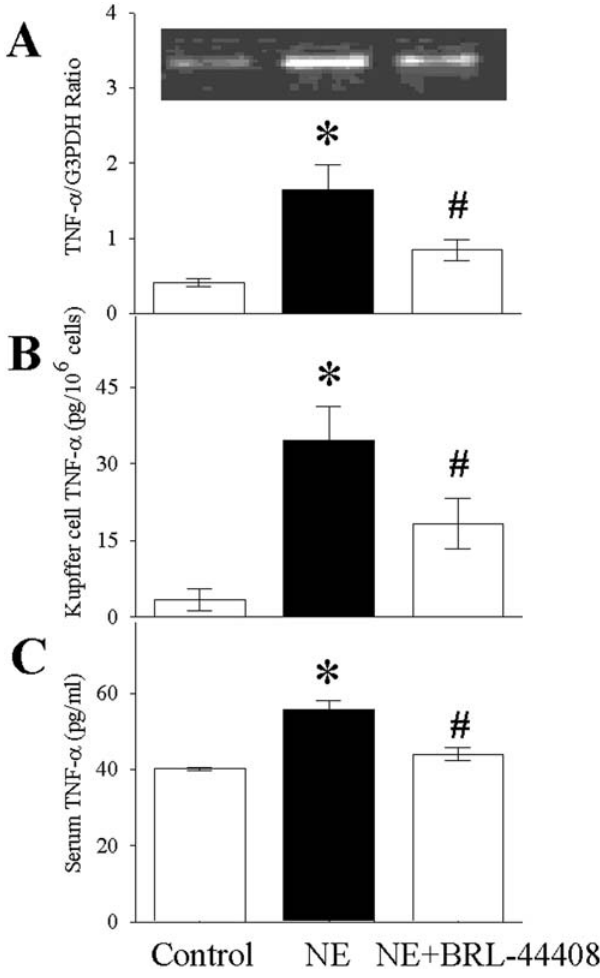
Figure 4. Portal infusion of NE induces a 2A -AR-dependent TNF- a production in KCs. In vivo Alterations in Kupffer cell gene expression ( A ) and protein levels of TNF- a ( B ) as well as serum TNF- a levels ( C ) after administration of NE, NE combined with BRL-44408 maleate for 2 h through the portal vein. A representative gene and ratio of TNF- a and housekeeping gene G3PDH are presented in panel ( A ). Values (n=5/group) are presented as mean 6 SE and compared by one- way ANOVA and Student-Newman-Keul’s method. *P , 0.05 vs. Control; # P , 0.05 vs. NE.